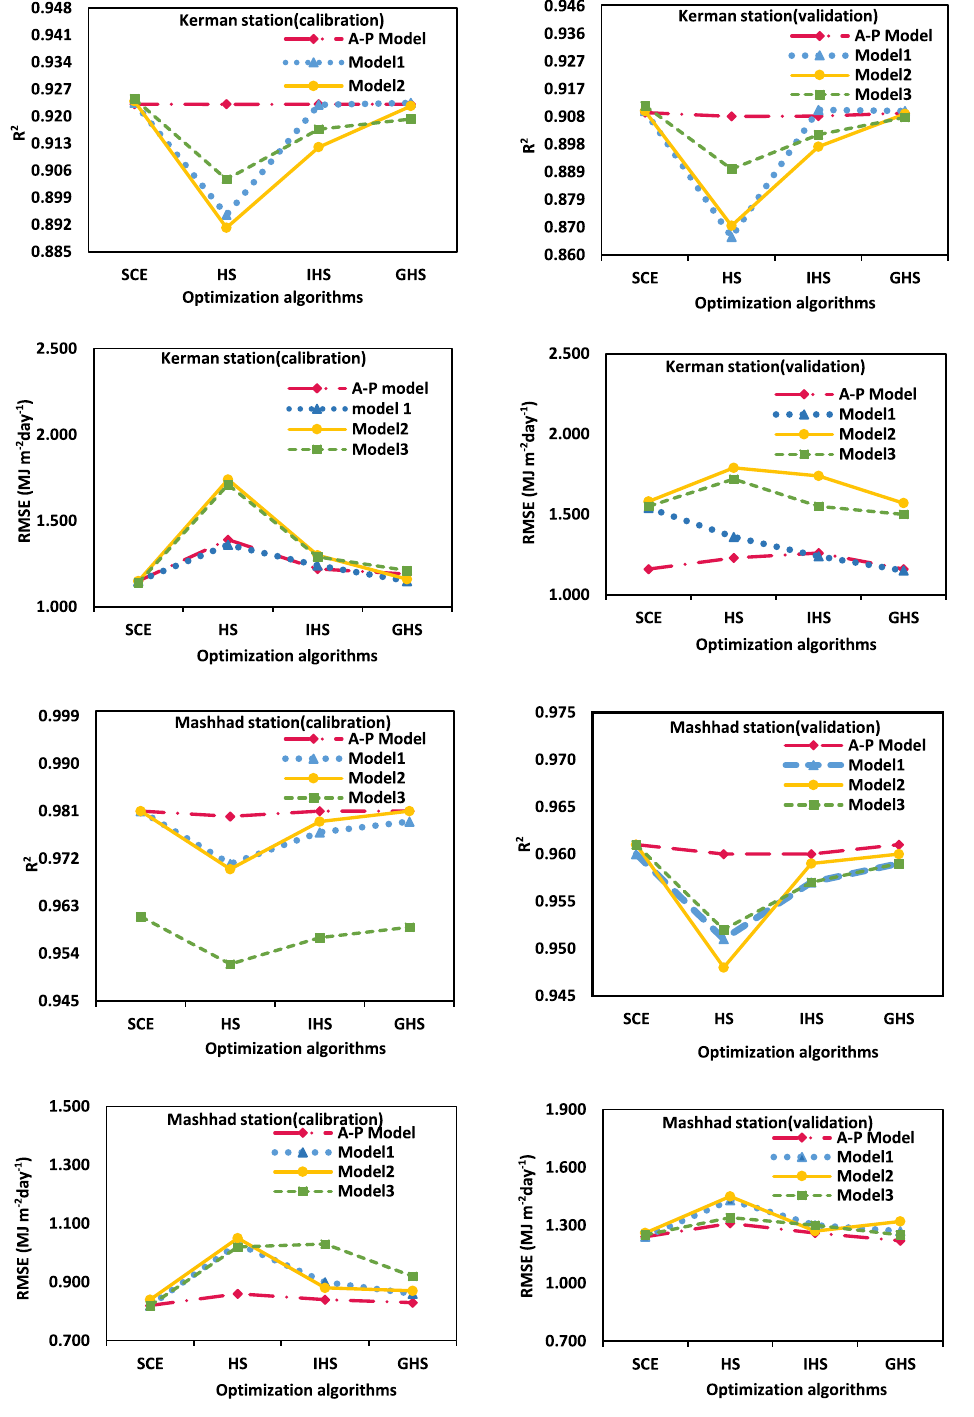
Figure 3. Comparison R 2 and RMSE between the calibrated and validation model with different optimization algorithms for Mashhad and Kerman